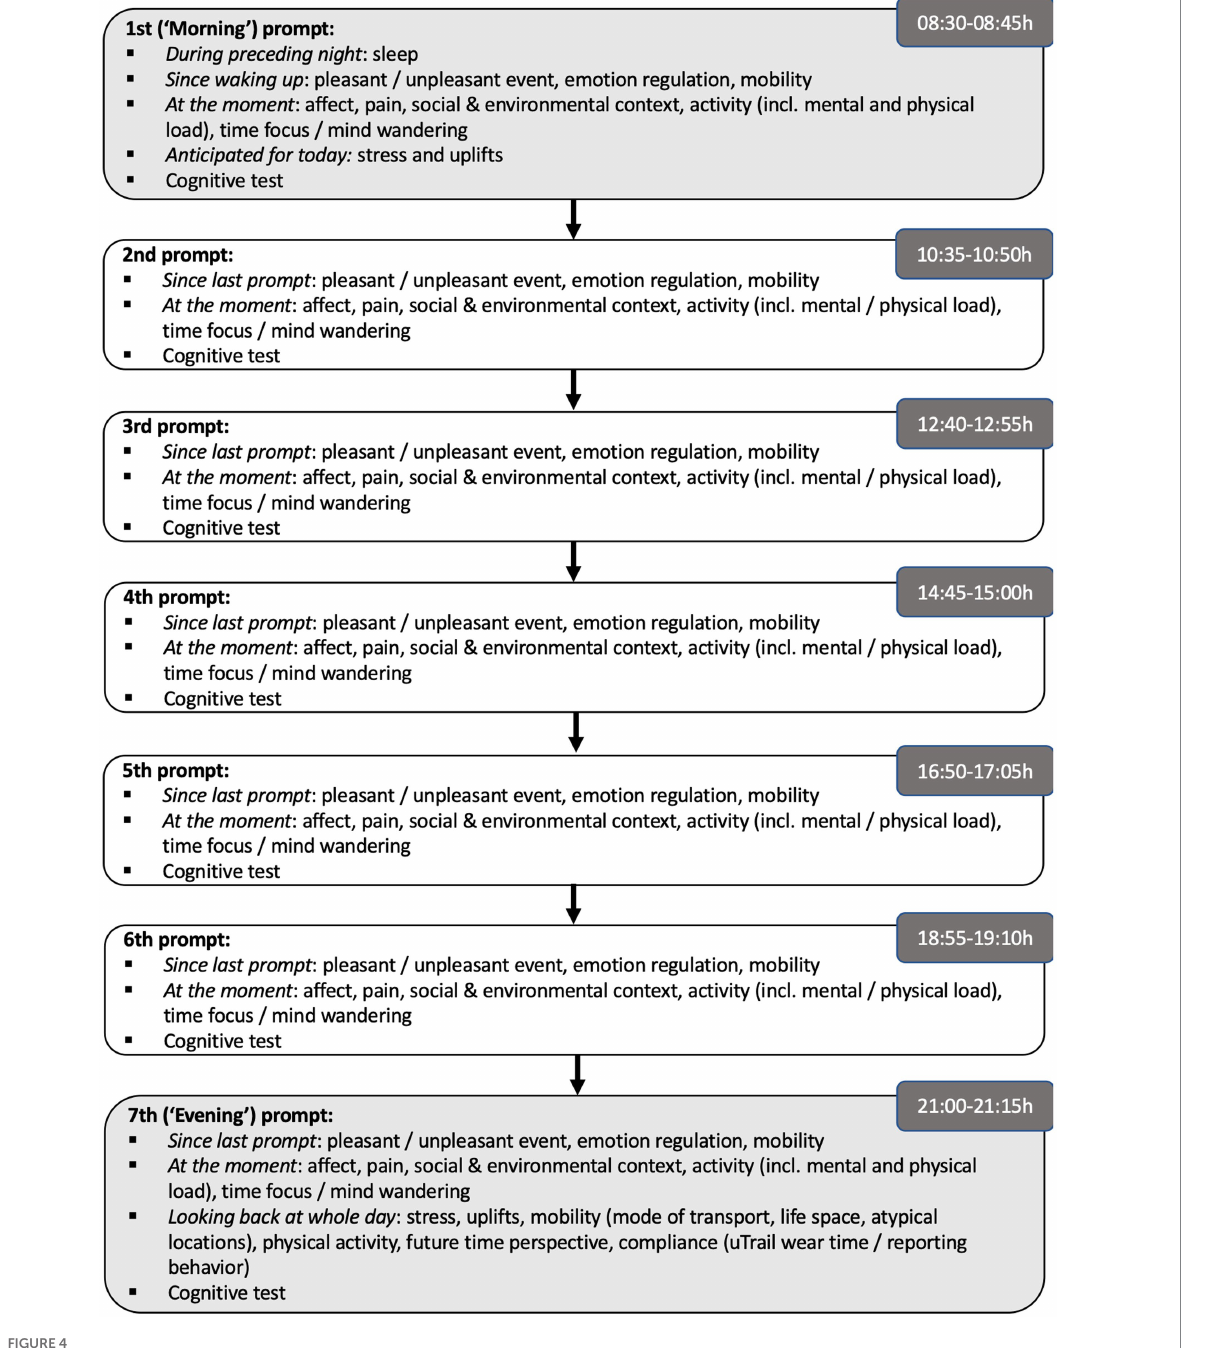
FIGURE 4 Diurnal flow of variables assessed across 7 prompts per